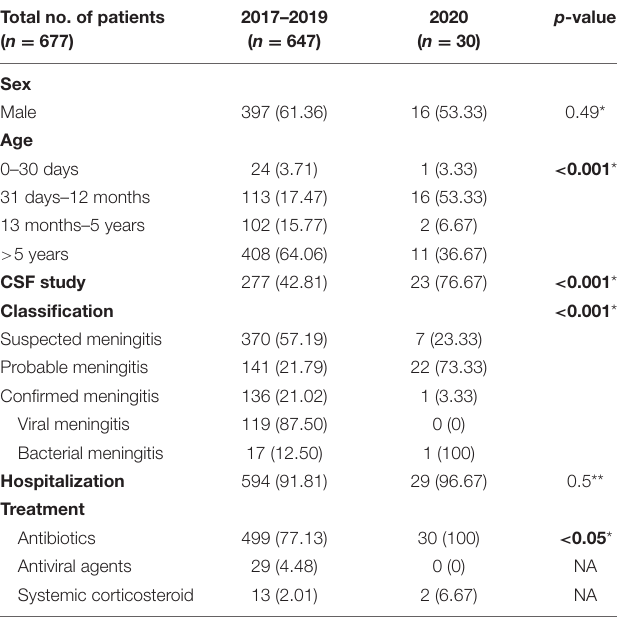
TABLE 1 | The demographic and clinical characteristics of the study population before and after the COVID-19 outbreak. Total no. of patients ( n = 677)